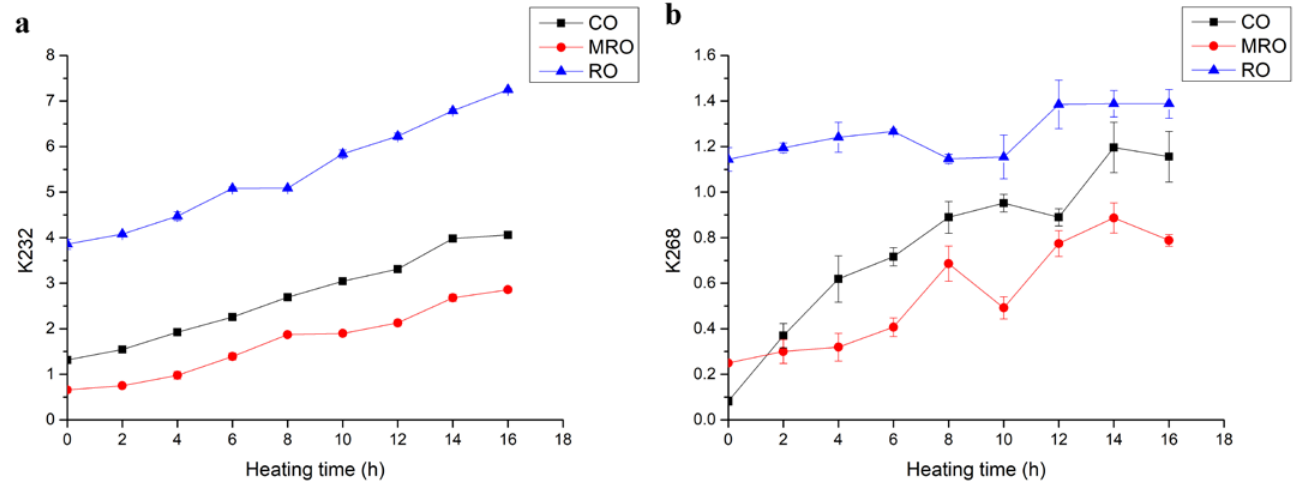
Figure 5. Changes in ( a ) K232 and ( b ) K268 in three kinds of camellia oil during heating.